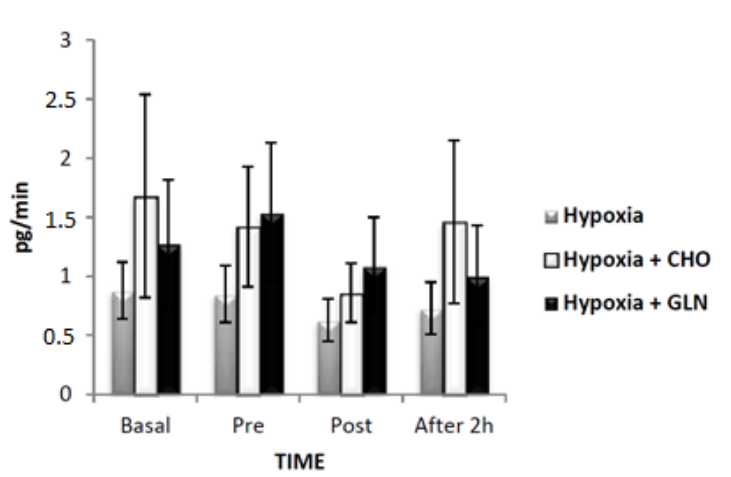
Figure 6. The results of IL-6 secretory (pg/min) was described by mean ± Standard Error (SE). The interaction of group versus time was analyzed by Analysis of Variance (ANOVA) for repeated measures followed by post hoc of Tukey test. The level of significance was set at p < 0.05. n = 15 volunteers. Hypoxia + CHO = Hypoxia + carbohydrate and hypoxia + GLN = hypoxia + glutamine.